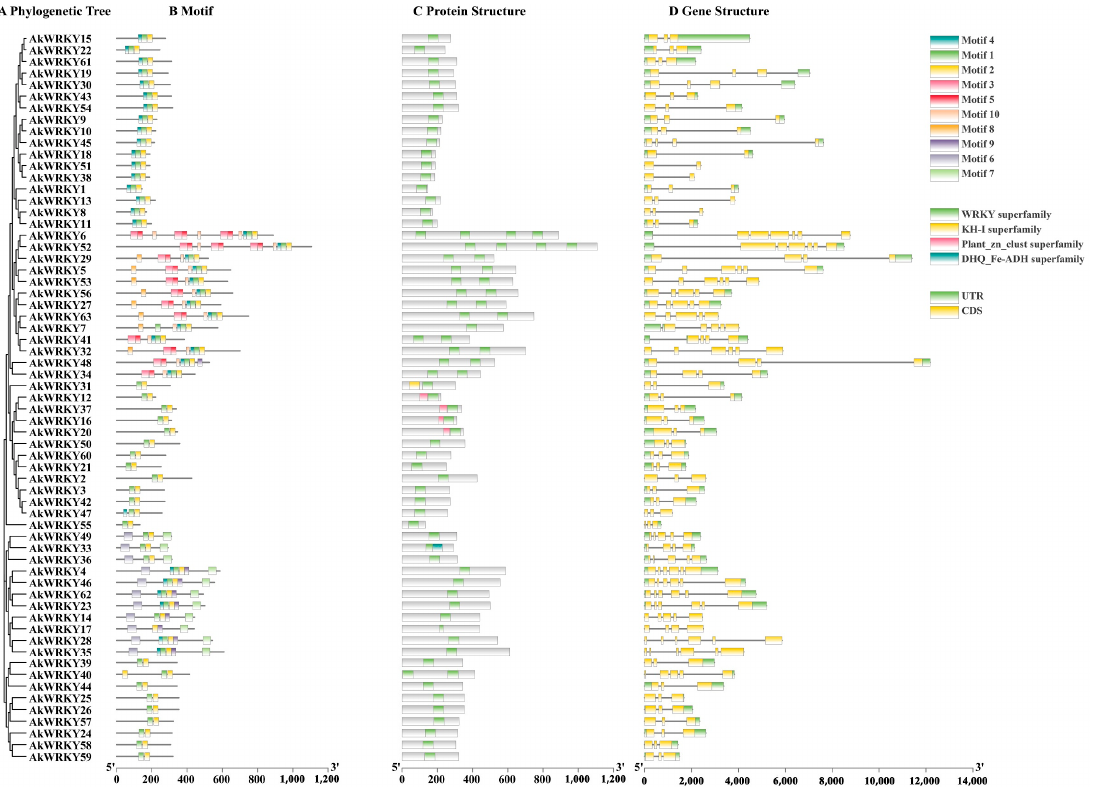
Figure 1. The chromosomal location of the WRKY genes in A. trifoliata . The red lines in the inner circle represent the gene pairs from fragment duplication. Genes marked in black are WGDs or fragment duplications, genes marked in blue are dispersed duplications, and genes marked in green are tandem duplications.